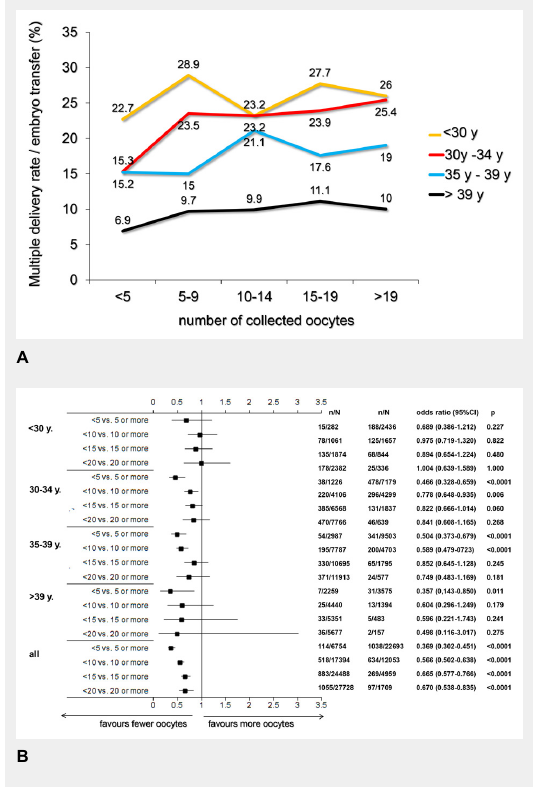
A Using the pooled FIVNAT-CH data, the relationship between the number of retrieved oocytes, the mean age of the treated patients at oocyte collection and the incidence of multiple deliveries was assessed during the observation period from 2005 to 2012. The incidence of multiple deliveries most strongly depended on the age of the treated women and to a lesser extent on the number of collected oocytes. B Number of multiple deliveries and its relationship with the number of collected oocytes and the age of the treated infertile women at oocyte collection, using the pooled FIVNAT-CH data collected between 2005 and 2012. Whereas the incidence of multiple deliveries per embryo transfer was generally lower among women aged 35 years or older, the incidence of multiple deliveries was very significantly age dependent (p <0.0001) and was lower if fewer than five or ten oocytes had been retrieved. Among women younger than 30 years the incidence of multiple deliveries was not related to the number of retrieved